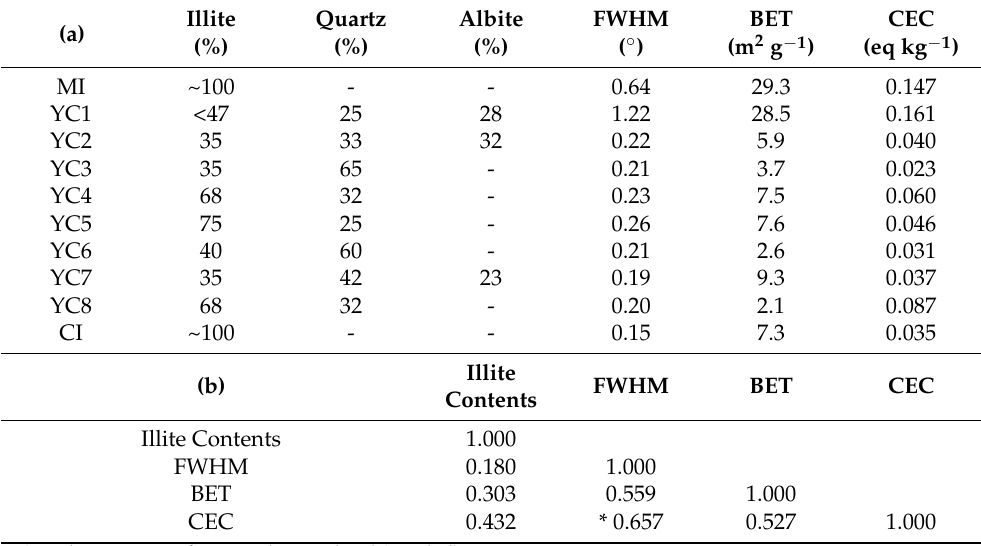
Table 1. ( a ) Individual mineral contents, full width at half maximum (FWHM) of 10 Å peak, cation exchange capacity (CEC) and specific area (BET) of clay samples, and ( b ) Spearman’s coefficients between mineralogical properties of clay